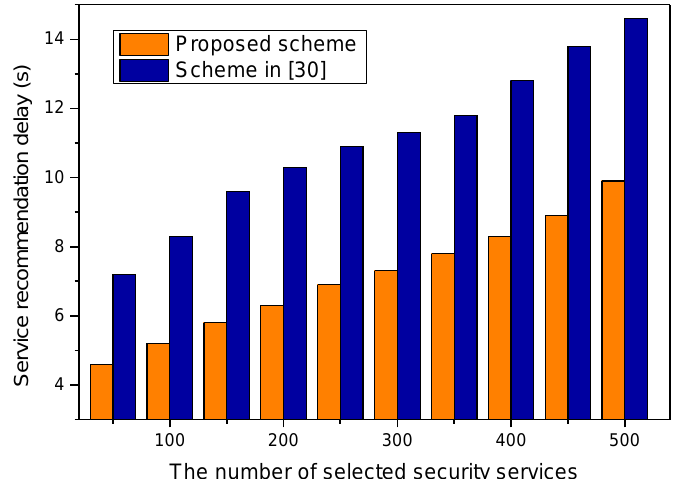
Figure 4. Security service recommendation delay.